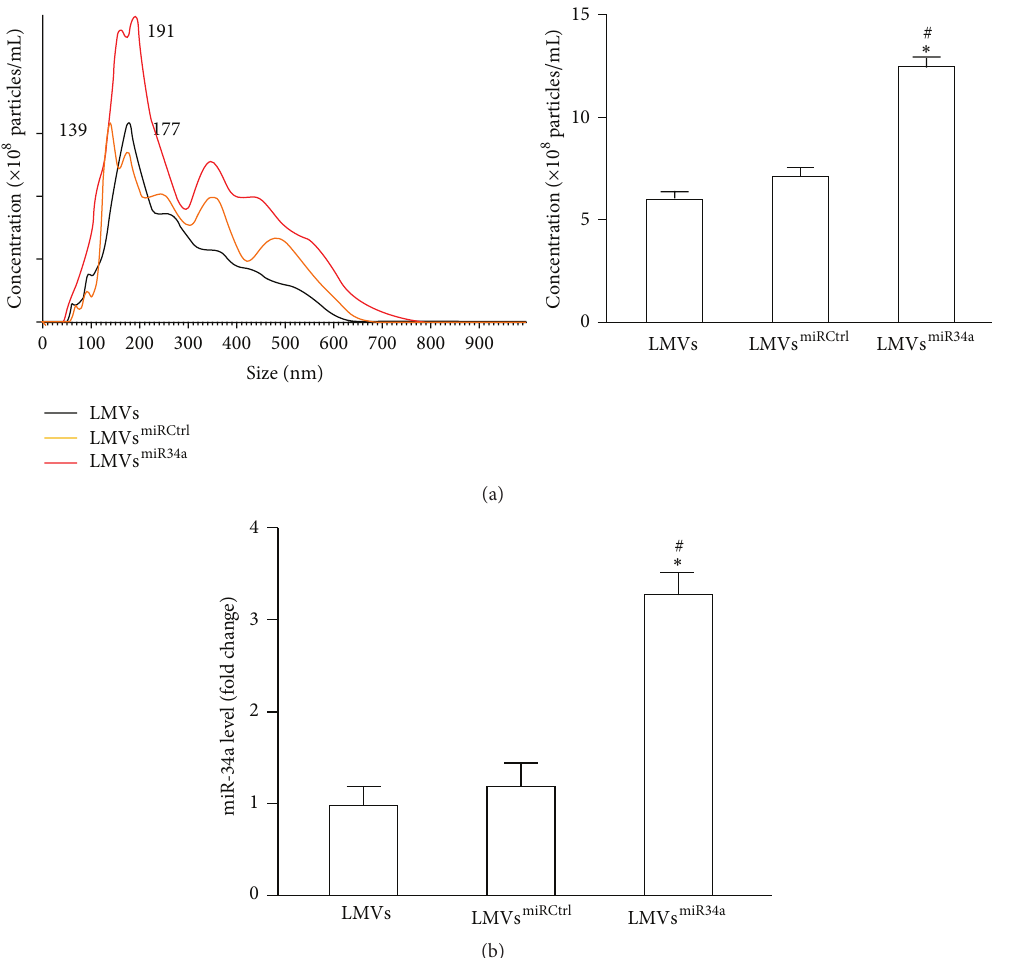
Figure 2: The particle number and miR-34a level of LMVs, LMVs miRCtrl , and LMVs miR 34 a . (a) Representative NTA plots of MV size distribution (left) and concentration (right). (b) qRT-PCR analysis of miR-34a level in LMVs, LMVs miRCtrl , and LMVs miR 34 a . Data represents mean ± SEM. ∗ 𝑃 < 0.05 versus LMVs; # 𝑃 < 0.05 versus LMVs miRCtrl . LMVs represent MVs generated from LSCs without transfection; LMVs miRCtrl represent MVs generated from LSCs transfected with miRCtrl; and LMVs miR 34 a represent MVs generated from LSCs transfected with miR34a